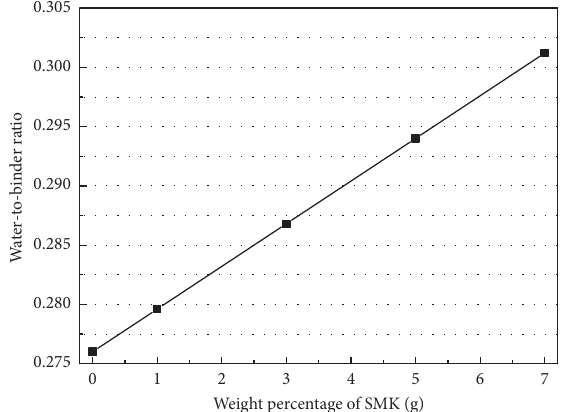
Figure 3: The cubes prepared for the compressive strength analysis and the YAW-300B compression machine.